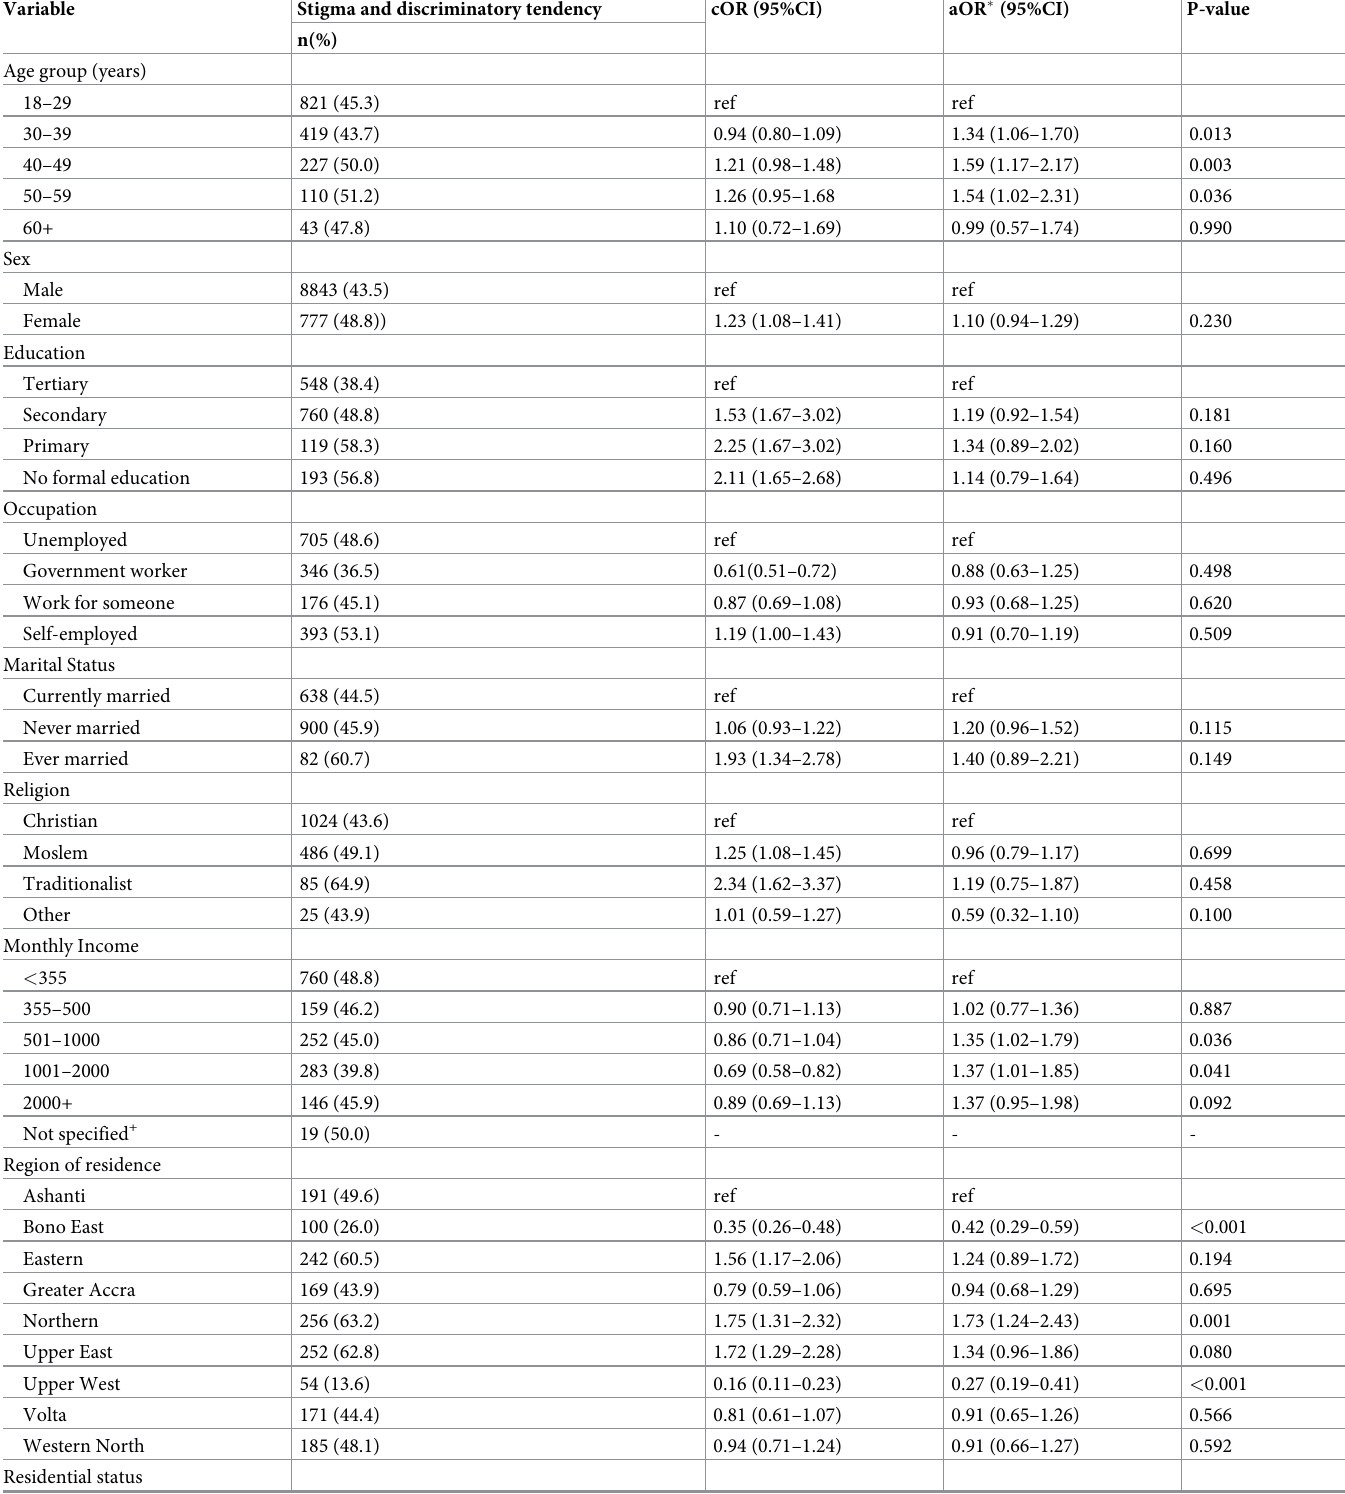
Table 5. Predictors of stigma and discriminatory tendencies towards COVID-19